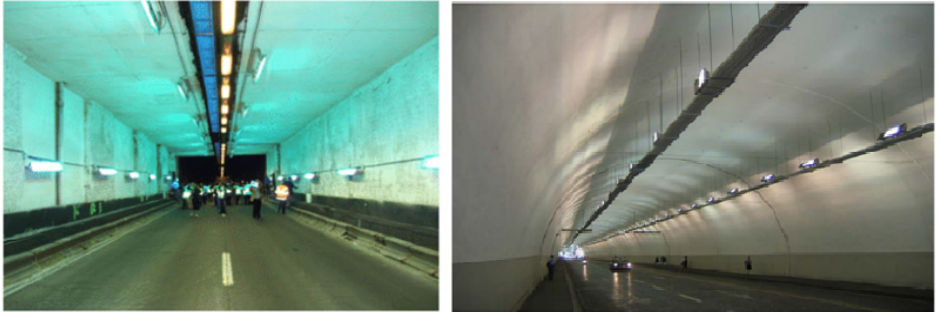
Figure 7. Tunnels after renovation: Leopold II tunnel in Brussels ( left ) [165] and “Umberto I” in Rome ( right ) [172] (RightsLink for Elsevier).